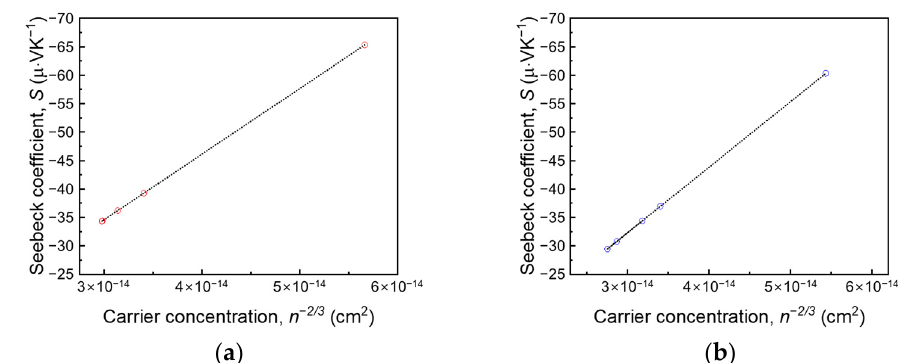
Figure 3. Seebeck coefficients ( S ) and n − (2/3) of ( a ) ZnO-doped ITO and ( b ) CeO 2 -doped ITO at various dopant concentrations. The Mott equation for metals and degenerated semiconductors was employed to calculate S using the measured carrier density.